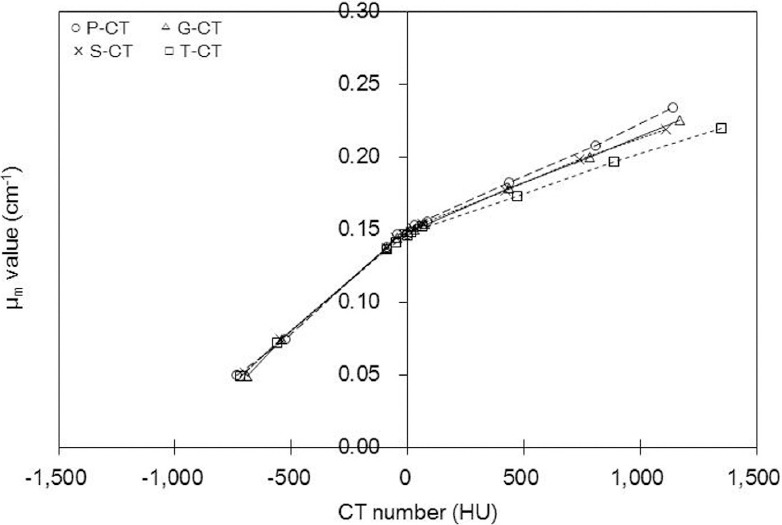
Attenuation coefficients (μm values; cm-1) as a function of the mean CT number derived from each of the four scanners (ο P-CT, ΔG-CT, ×S-CT, □T-CT). The differences between the bilinear calibration lines, especially between the P-CT and T-CT scanners, tended to increase as indicated by the slope of the regression line at HU > 0. They were y=7.4×10-5+0.149 [ο P-CT], y=6.6×10-5+0.149 [ΔG-CT], y=6.6×10-5+0.149 [×S-CT], and y=5.5×10-5+0.147 [□T-CT]